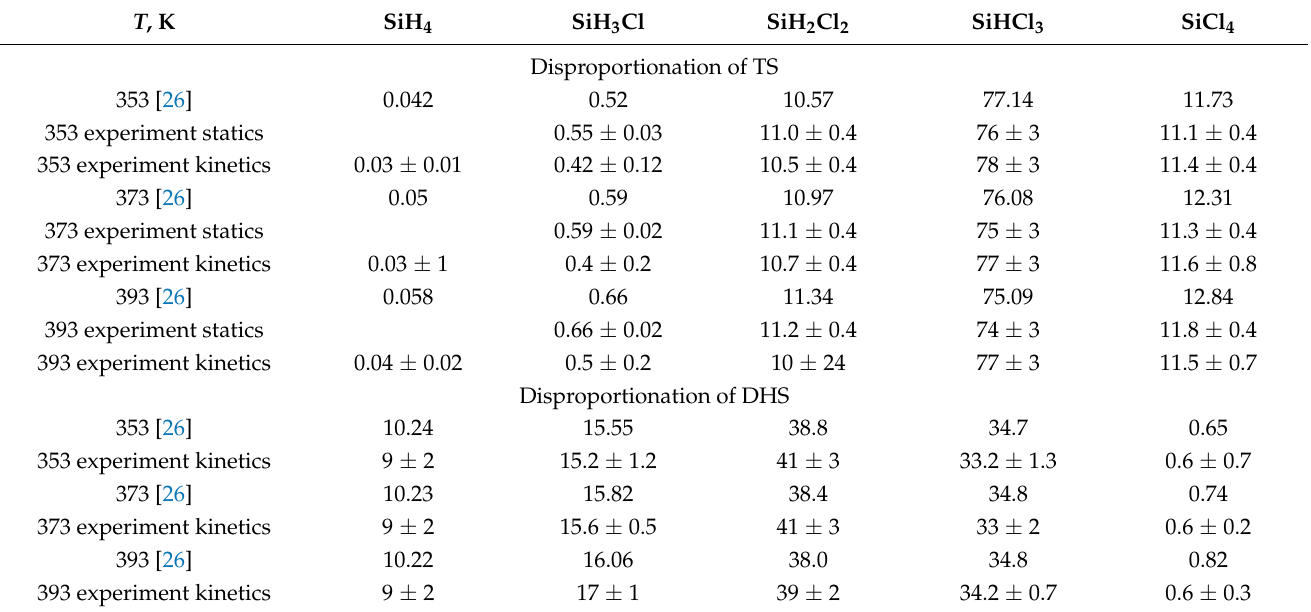
Table 6. Compositions (in mole percentages) of equilibrium mixtures of products of TS and DCS disproportionation for temperatures 353, 373, and 393 K calculated according to the data [26] and experimental